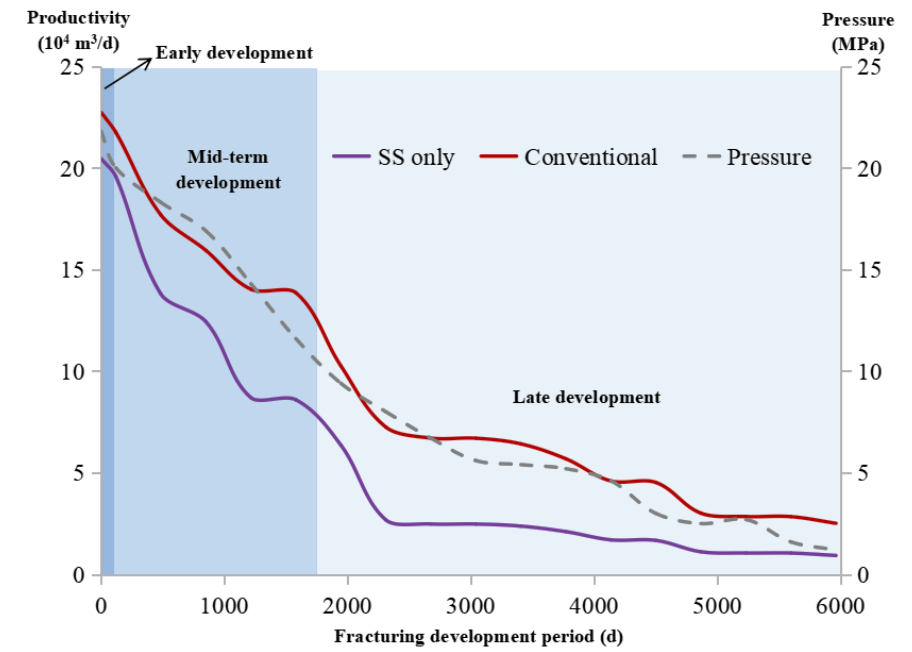
Figure 10. Influence of pollution on gas reservoir production under the condition of stress-sensitive pollution only.